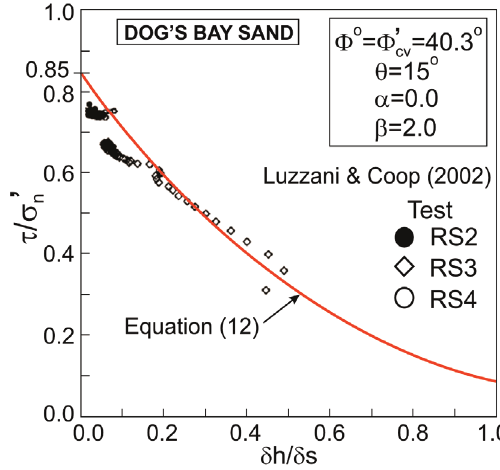
Fig. 11. Stress-dilatancy relationship for ring shear tests on Dog’s Bay